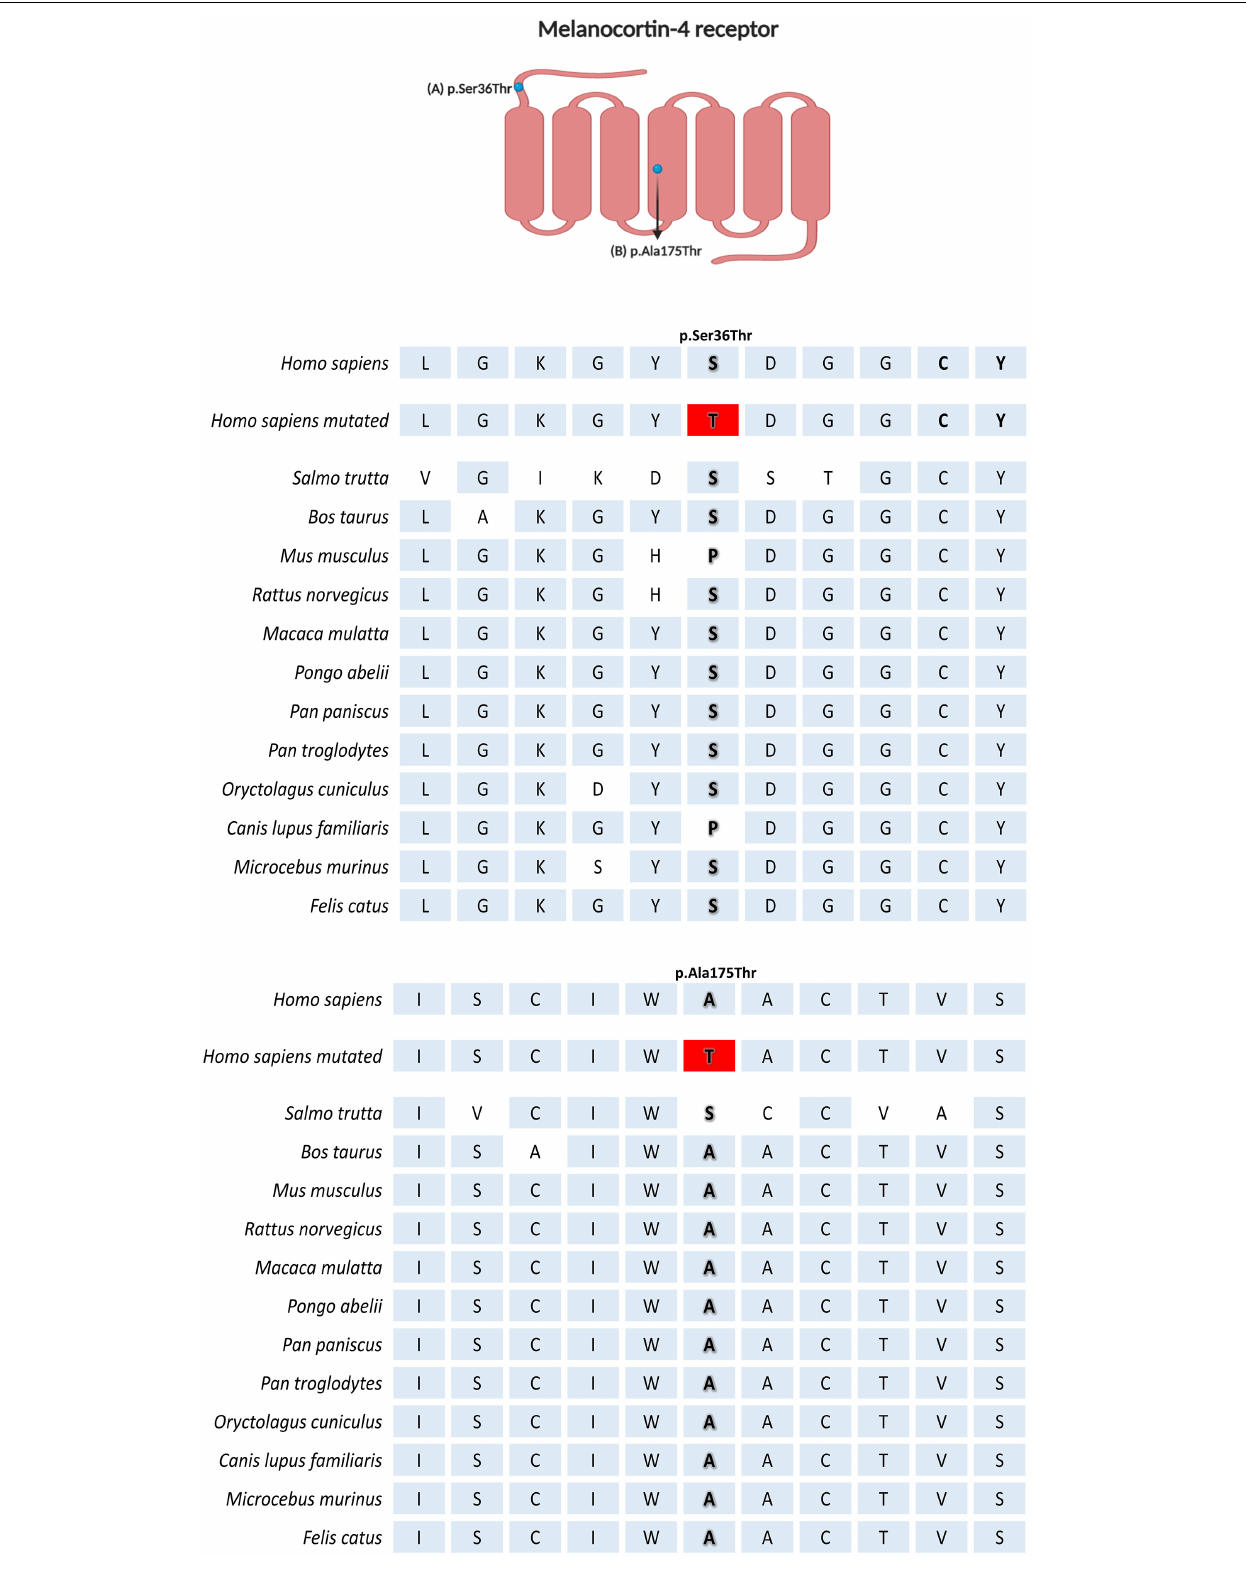
Frontiers in Genetics |